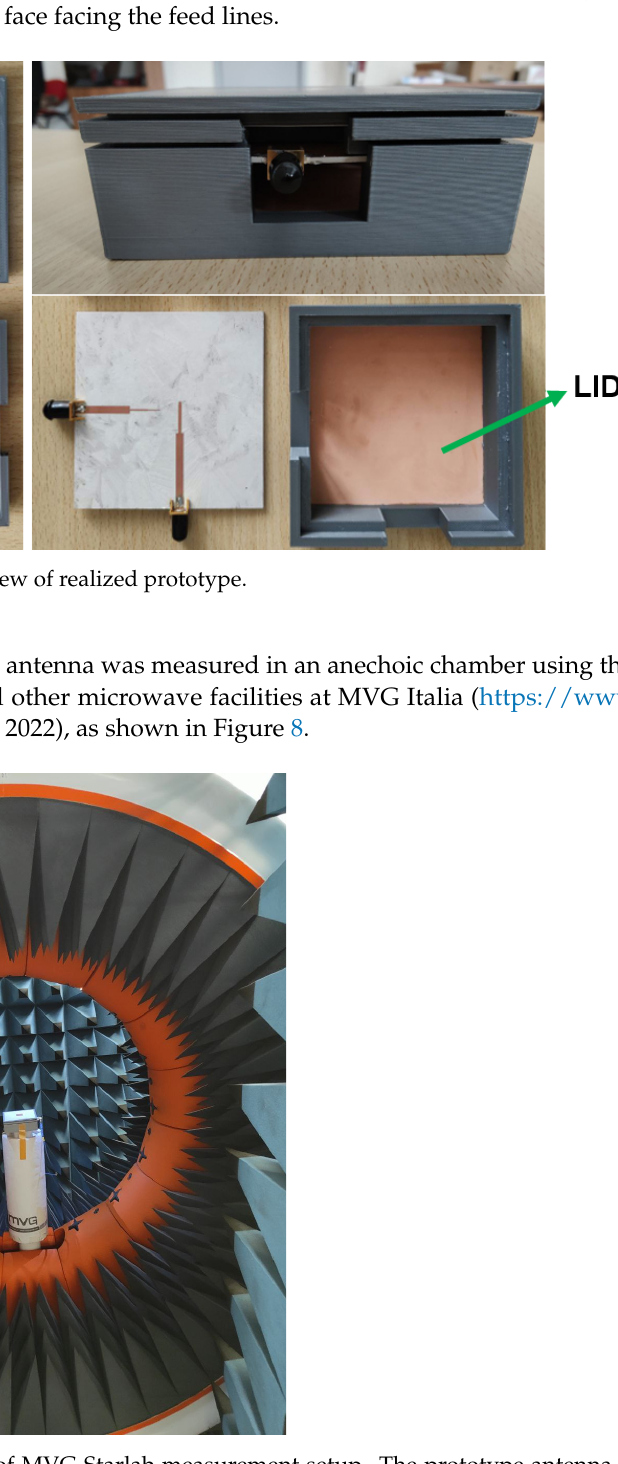
Figure 8. A picture of MVG Starlab measurement setup. The prototype antenna is over the cen- tral